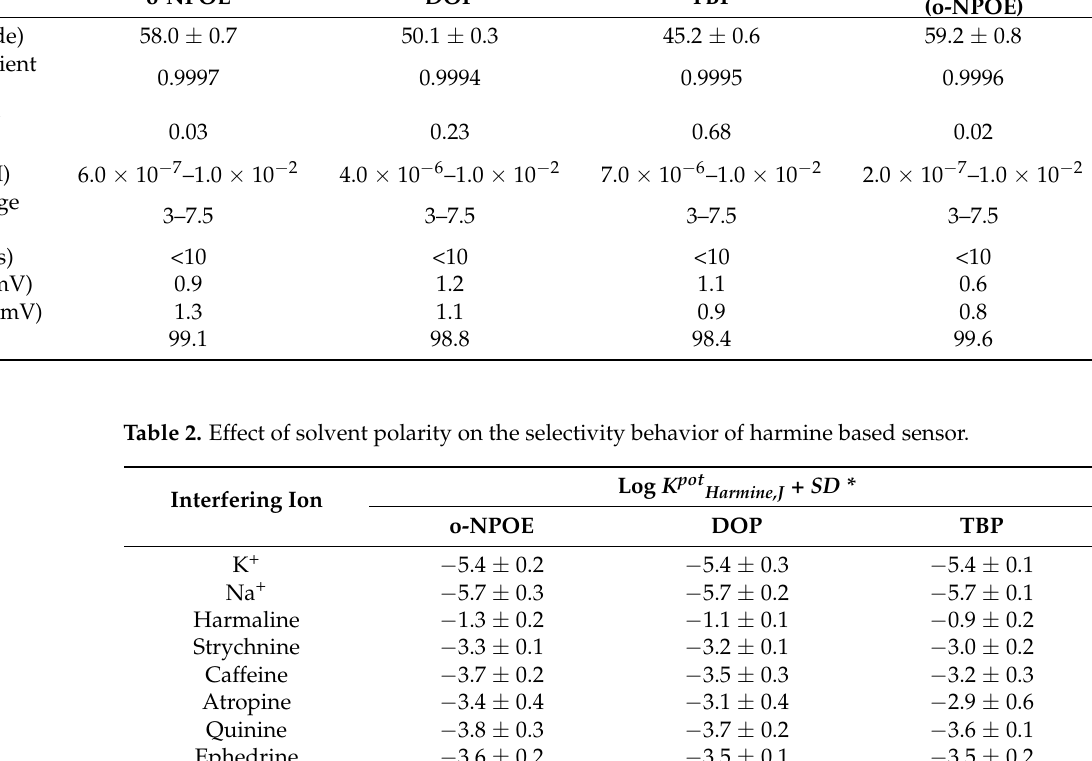
Table 2. Effect of solvent polarity on the selectivity behavior of harmine based sensor.